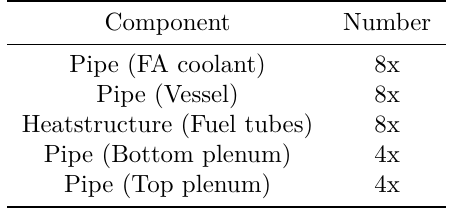
Table 2. List of TRACE components utilized in the single assembly VR-1 model.